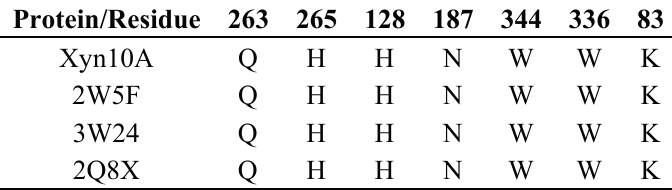
Table 3. The subsite − 1 residues in GH10